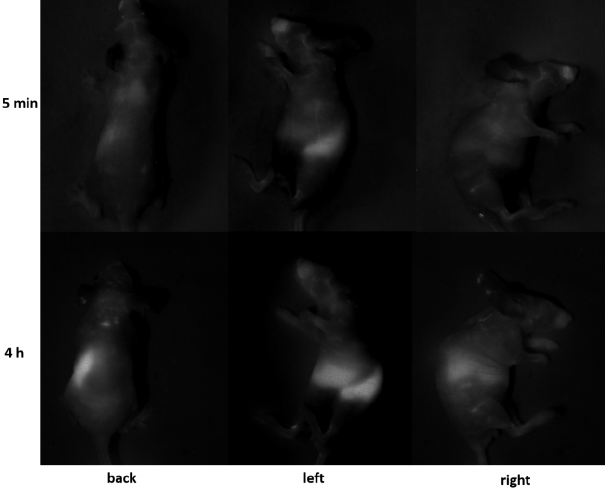
Fig. 6. SWIR imaging of nude mice. Five minutes (up) and four hours (down) after injection of PDTSDTBT nanoparticles, SWIR imaging of the back, left- and right-hand sides of nude mice.